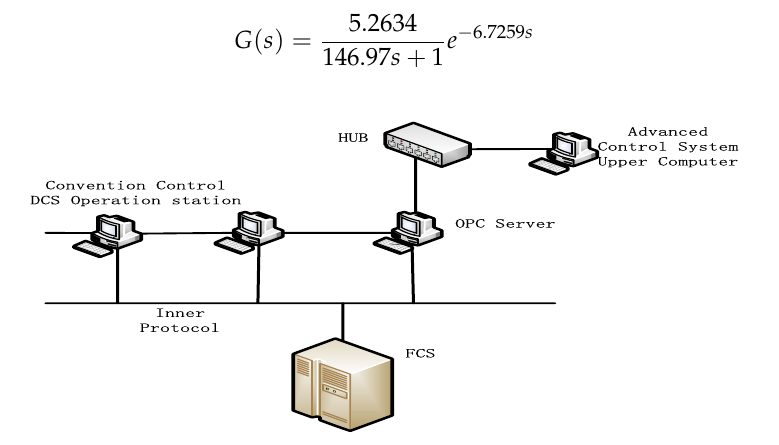
F M I T  Figure 8. Inverse controller based on the IT2-FM design scheme. 5. Simulation Studies A cyber-physical system (CPS) is a new complex system with heterogeneous computing units and physical objects, which are highly integrated and interactive in the network environment [38]. In the control of the ethylene cracking furnace outlet temperature system, the construction of communication, computing and control between the physical layer and the information layer is an essential part. The advanced process control system is implemented in an industrial upper computer, which is connected with the object linking and embedding for process control (OPC)